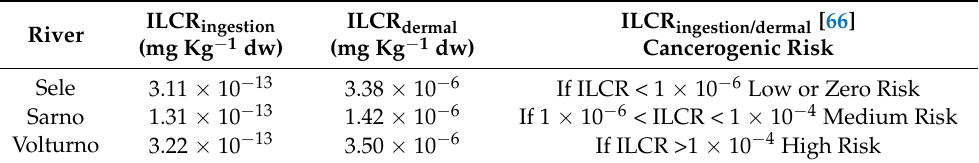
Table 8. Incremental lifetime cancer risk values (ILCR ingestion and ILCR dermal ) due to exposure by ingestion and dermal contact from PAHs present in the estuarine sediments of the Sele, Volturno, and Sarno